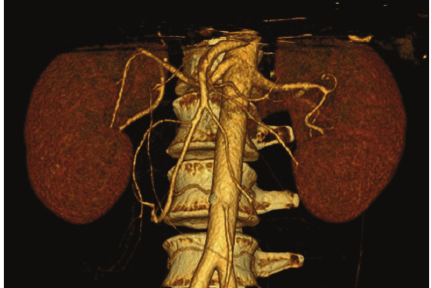
Figure 1: Angio-computed tomography of the kidneys of the 2nd donor: on both sides single strong renal artery without signs of kidney pathologies.